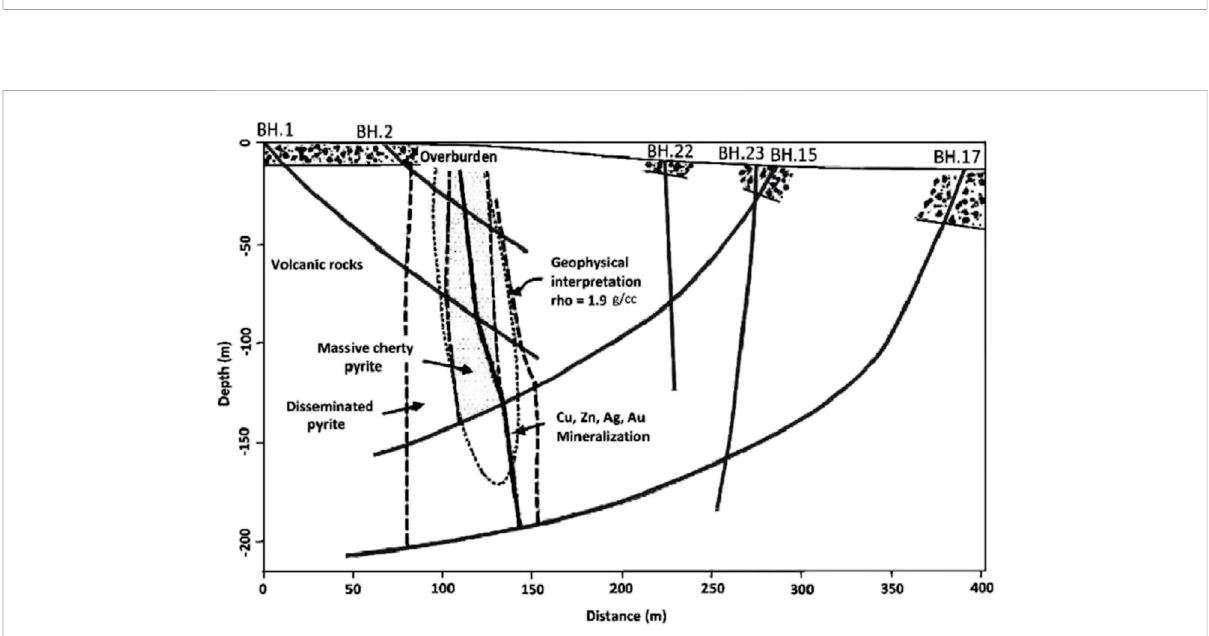
FIGURE 13 Drilling information and geological section of the Mobrun sul fi de body with its geophysical interpretation (Grant and West 1965).